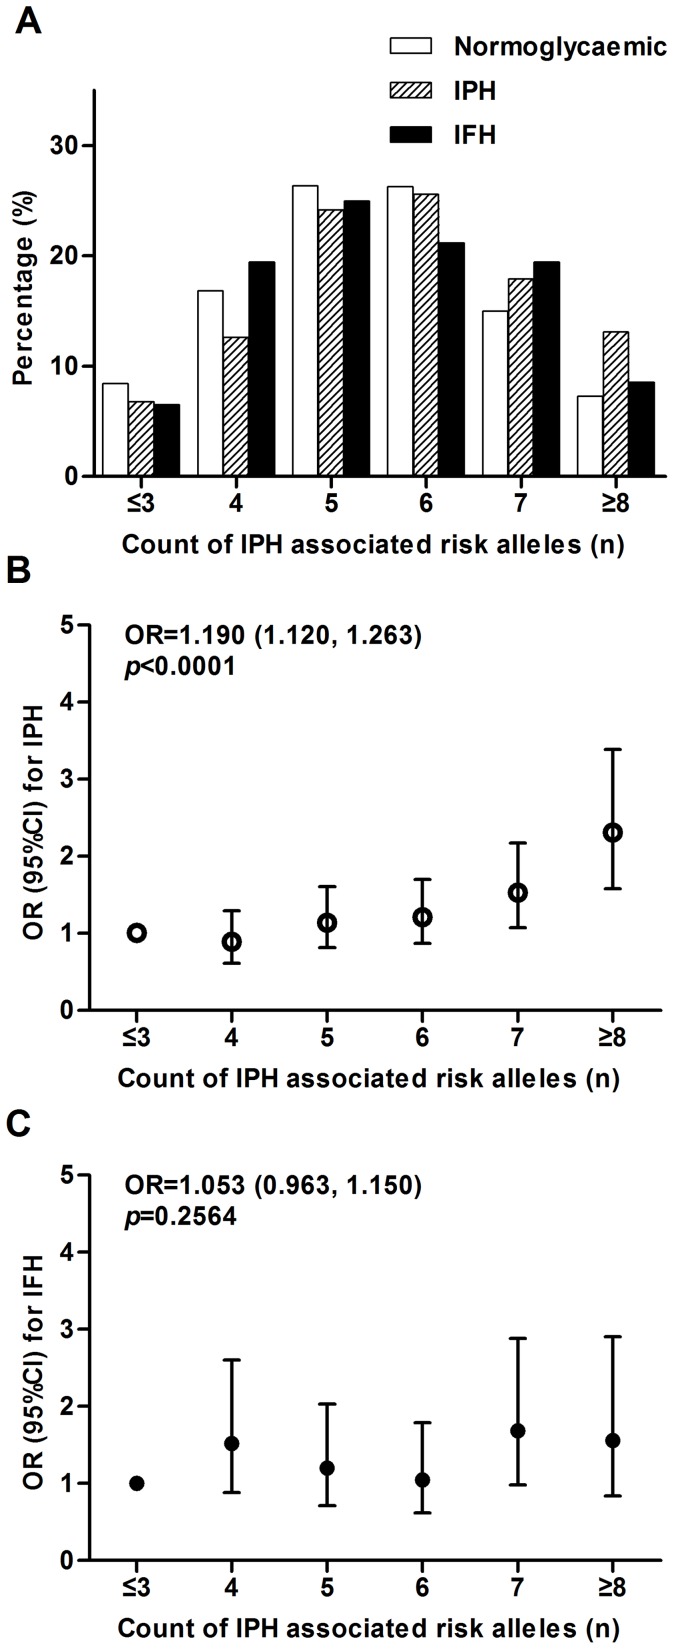
Combined effects of increasing numbers of isolated postprandial hyperglycaemia-associated risk alleles from TCF7L2, CDKAL1, KCNQ1, PRC1, TP53INP1 and GCKR.A: The isolated postprandial hyperglycaemia-associated risk allele distribution in controls, participants with isolated fasting hyperglycaemia and isolated postprandial hyperglycaemia. Each additional risk allele increased the risk of isolated postprandial hyperglycaemia by 1.19-fold (p<0.0001) (B) but not the risk of isolated fasting hyperglycaemia (C). OR and 95% CI were plotted on the y-axis for the corresponding number of risk alleles on the x-axis (black circles  =  risk of isolated fasting hyperglycaemia; white circles  =  risk of isolated postprandial hyperglycaemia). B: Participants harboring eight or more risk alleles had a 2.31-fold increased risk for isolated postprandial hyperglycaemia (p<0.0001) compared with the reference group. C: However, risk for isolated fasting hyperglycaemia was not increased as risk allele number increasing. IFH, isolated fasting hyperglycemia; IPH, isolated postprandial hyperglycemia.